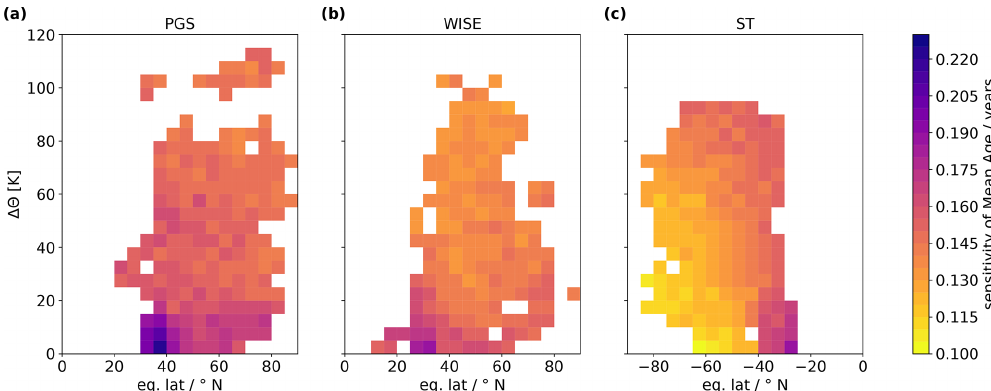
Figure 5. Latitude–altitude distribution of sensitivities of mean age from the exTR–TR method to uncertainties in all considered input parameters, calculated for PGS (a) , WISE (b) and SouthTRAC (c) campaigns. Altitude is given in (cid:49)θ . Horizontally, data are sorted by eq. lat.